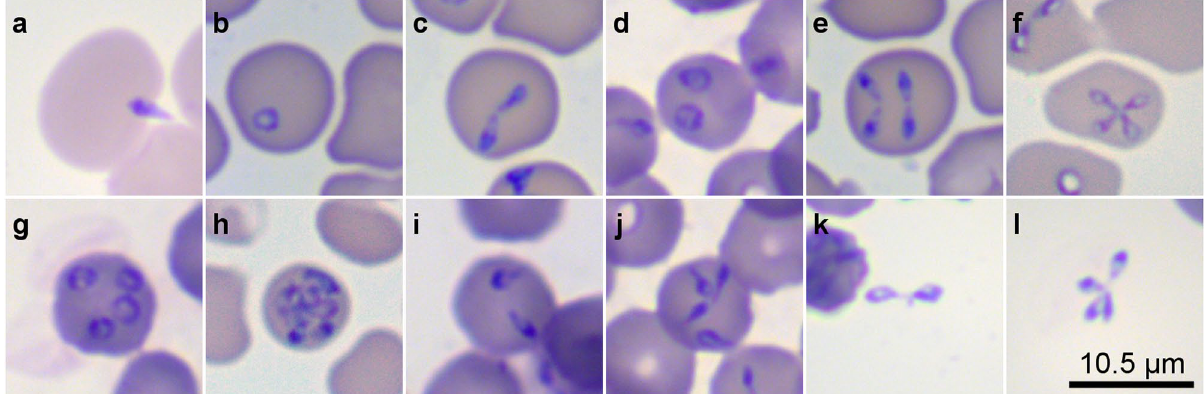
Figure 1. B. divergens forms inside and outside erythrocytes were identified in in vitro cultures by Giemsa staining. ( a ) A free merozoite invading a human erythrocyte. Panels b–j show different stages within the human erythrocyte. ( b ) Single round trophozoite. ( c ) Paired pyriforms, a stage formed by two attached pear-shaped sister cells. ( d ) Double round trophozoites, ( e ) Double paired pyriforms. ( f ) Tetrad ( g ). Quadruple round trophozoites. ( h ) Multiple parasites. ( i ) Double unattached pyriforms. ( j ) Quadruple unattached pyriforms. ( k ) Intact paired pyriform outside the erythrocyte. ( l ) Intact tetrad outside the erythrocyte. Slides were examined with a Primo Star microscope (Zeiss, Germany) at 100X